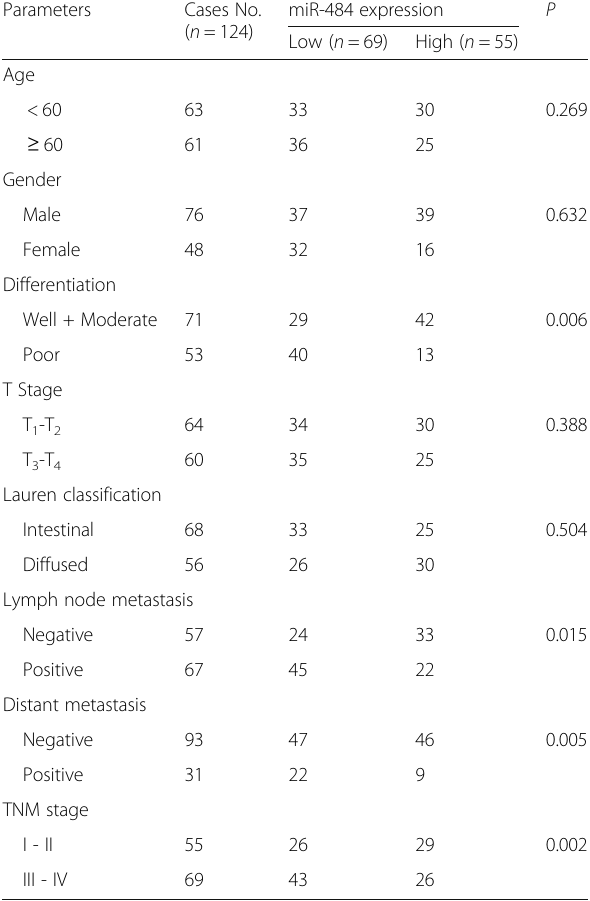
Table 1 Correlation between miR-484 expression levels and clinical features in gastric cancer patients